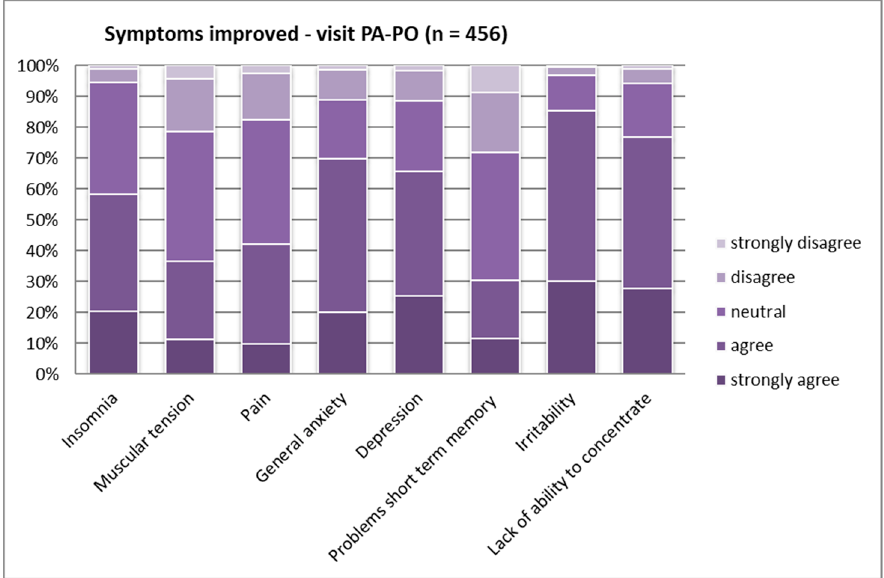
Figure 8. Symptoms improved by PA visitation—Poland ( p ≤ 0.01).